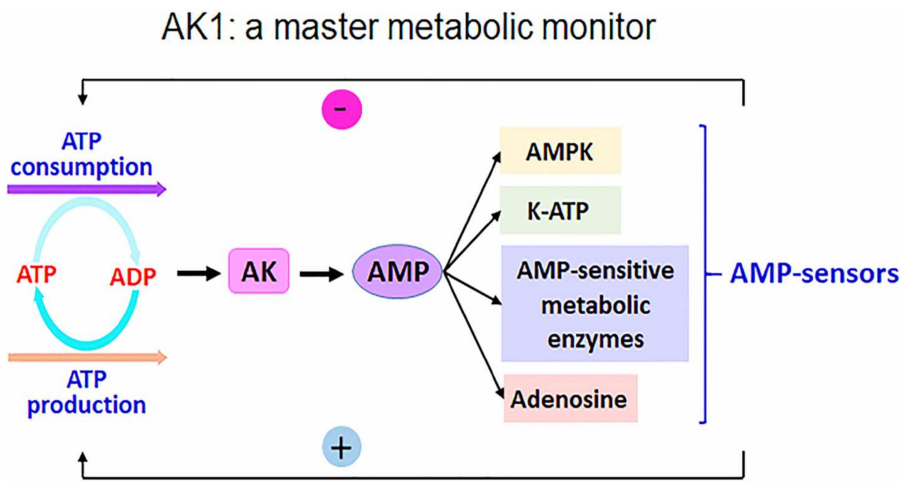
Figure 1. Adenlyate kinase (AK) enzyme activity. AK enzymes are often used as a metabolic monitor of energy load, leading to the activation or inhibition of downstream enzymes [11]. ATP, adenosine triphosphate; ADP, adenosine diphosphate; AMP, adenosine monophosphate; AMPK, AMP-activated protein kinase; K-ATP, ATP-sensitive potassium